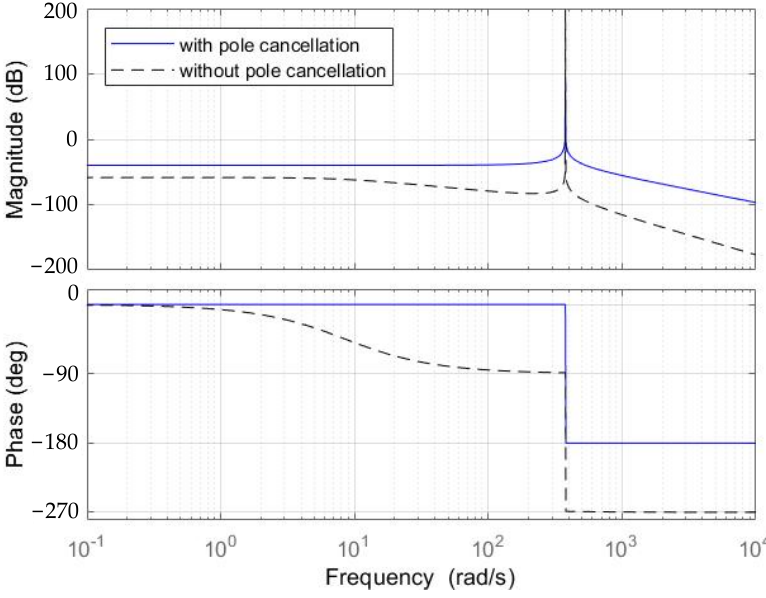
Figure 5. Bode plot of the compensator with and without pole cancelation. However, even after the pole cancelation, the phase margin at ω C is zero and a lead compensator is needed to add a phase margin of 45 ° at ω C to improve the stability. The dashed line in Figure 6 shows the frequency response after adding the lead compensator and it is noted that the system is stable, but the gain is almost constant at low frequencies. In order to exhibit a large gain at low frequencies, a lag compensator needs to be added to the compensator, and the solid lines in Figure 6 show the final compensator frequency response.